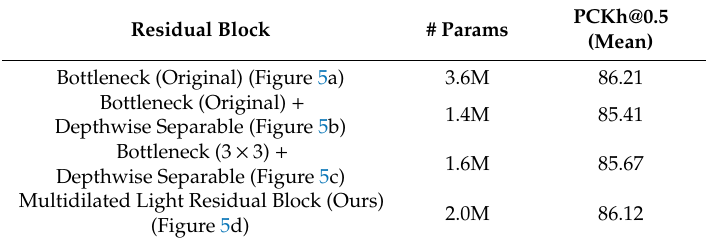
Table 2. Results for MPII validation sets in a single-stack hourglass network, depending on the type of residual block. (# Params is total number of parameters in a single-stack hourglass